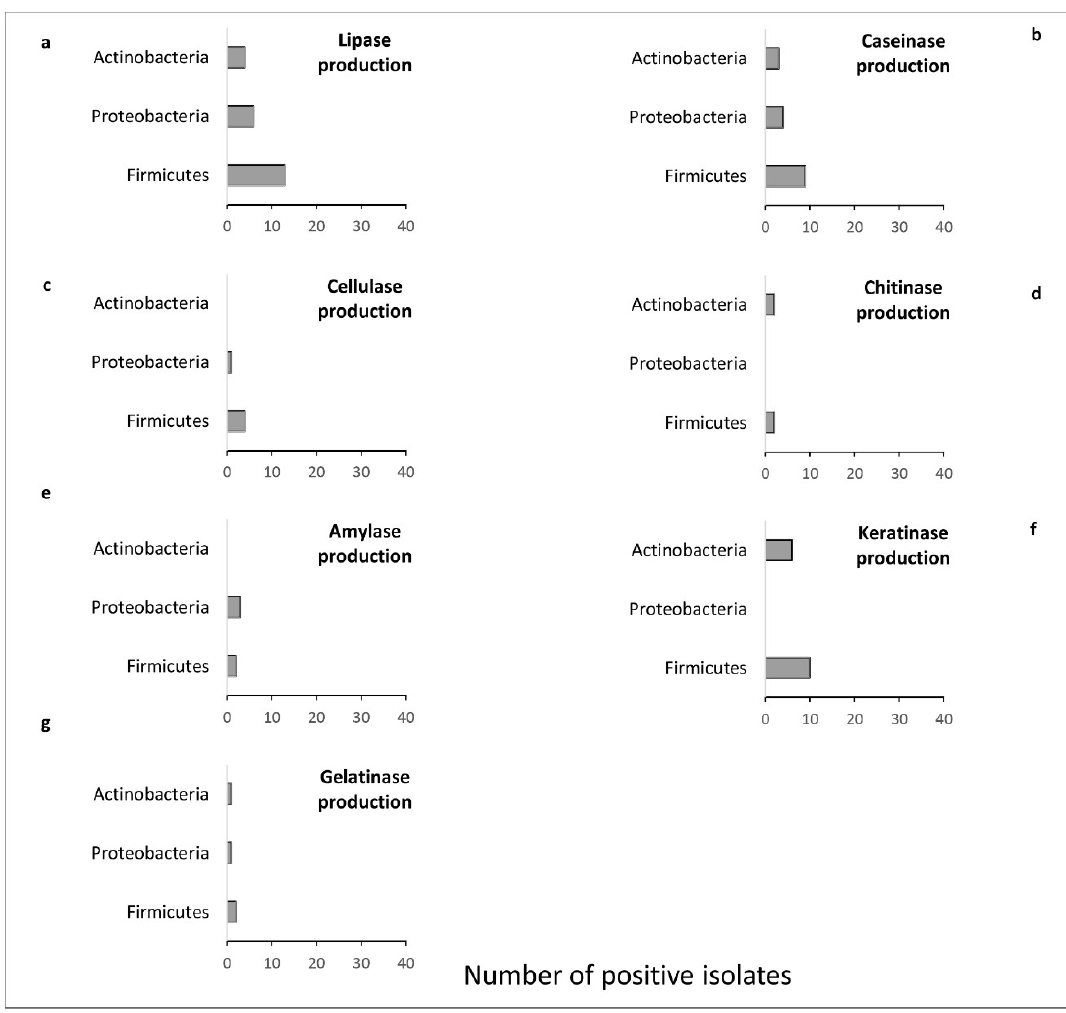
Figure 6. Summary of enzymatic activities found in each bacterial phylum. ( a ) lipase production; ( b ) caseinase; ( c ) amylase; ( d ) chitinase; ( e ) cellulase; ( f ) gelatinase; ( g ) keratinase.